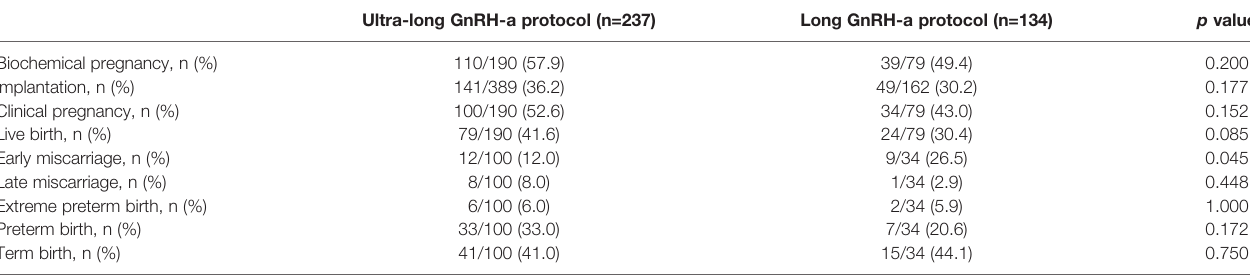
TABLE 3 | Clinical outcomes of the